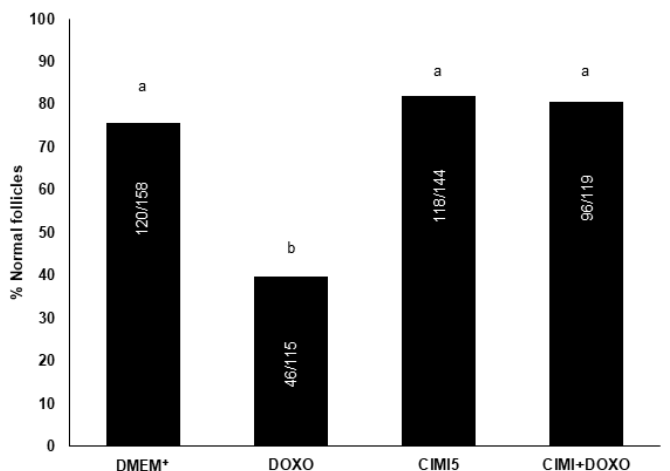
Figure 4. The percentage (mean ± SE) of normal follicles in ovaries cultured in DMEM + alone or supplemented with DOXO (0.3 µ g/mL), CIMI (5 ng/mL) and CIMI+DOXO (5 ng/mL + 0.3 µ g/mL). The percentage of normal follicles was evaluated using the chi-square test. a and b different lowercase letters indicate statistically significant differences between treatments ( p < 0.05). Numbers of follicles evaluated are shown within each column.